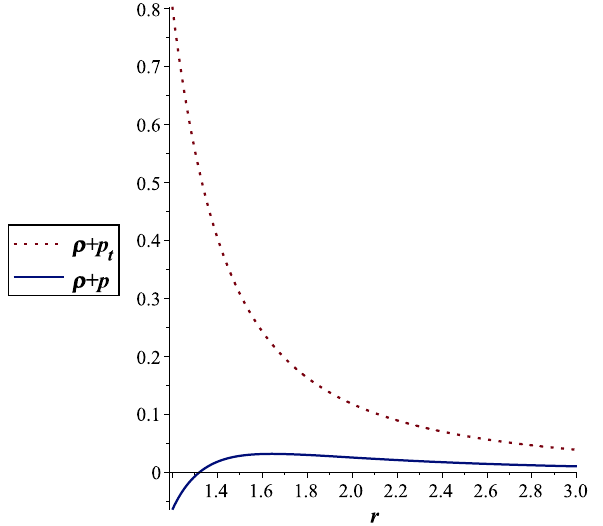
Fig. 9 The plot depicts the function p + ρ (solid line) and p t + ρ (dotted line) as a function of r where n = 3 ,ω = − 2 / 3 and r 1 (cid:9) 1 . 32.